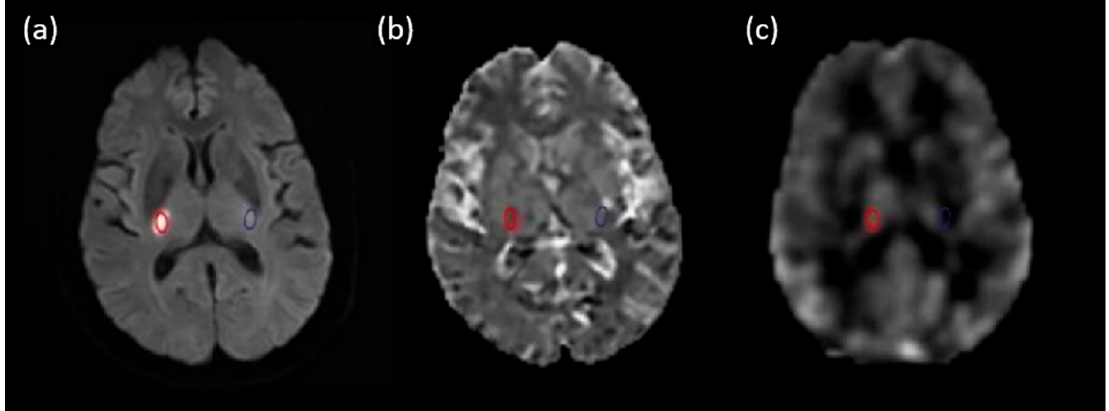
Figure 1. Illustration of ROI, which was placed on the lesion and marked with a red circle. ( a ) the reference DWI image (b = 1000). ( b ) MTRasym map. ( c ) CBF map. The contralateral to the lesion with a blue circle.